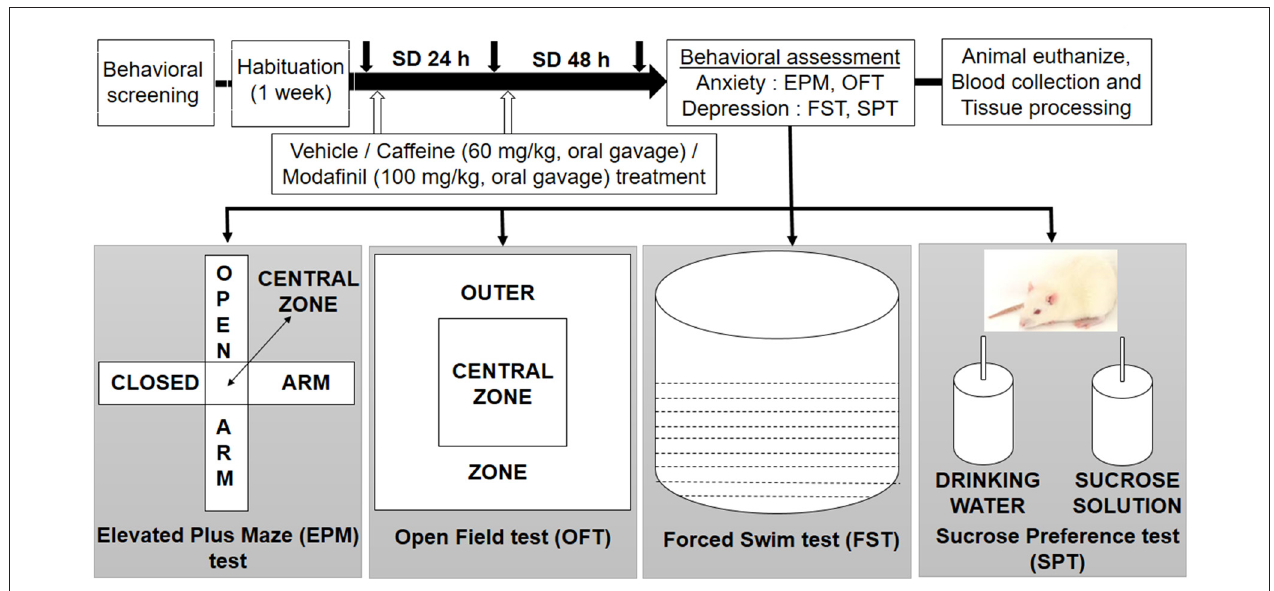
FIGURE 1 | Schematic design of the